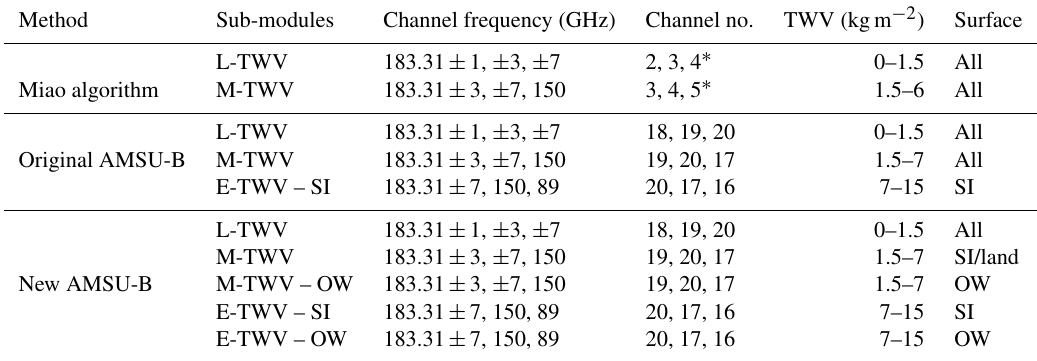
Table 1. Comparative structure of three TWV retrieval algorithms. SI represents sea ice only and OW – open water as surface types where the individual modules can be applied. L, M and E represent low-, mid- and extended-range TWV retrieval